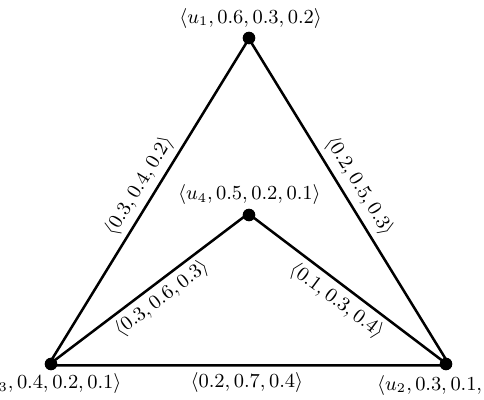
Figure 10. Single-valued neutrosophic graph Figure 10: SVNG